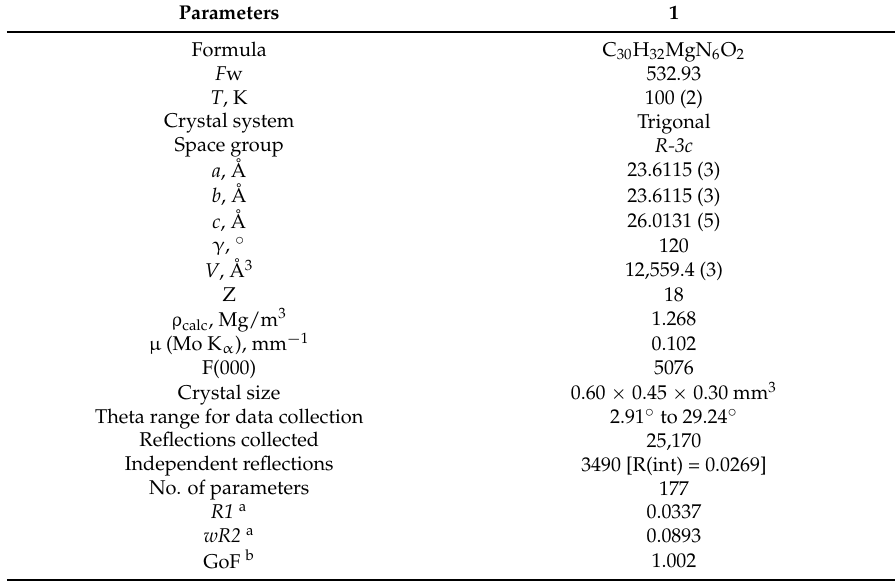
Table 1. Summary of crystal data for compound